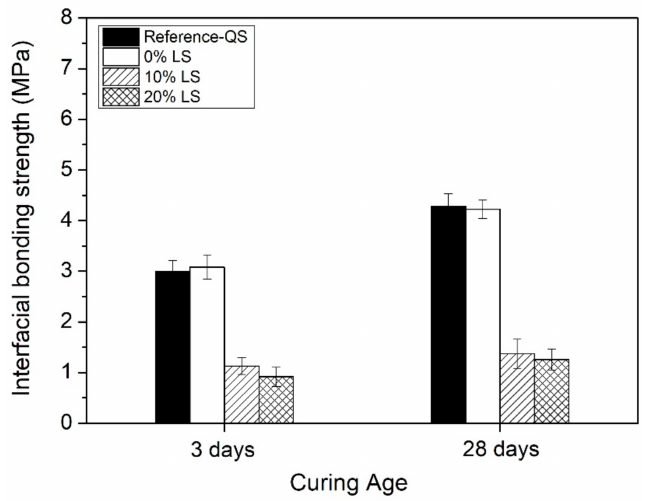
Figure 5. Interfacial bonding strength at different curing ages of 3 days, 28 days of MAPC mortar samples with quartz sand (Reference-QS) and limestone fines (LS) at different contents of 0%, 10%,